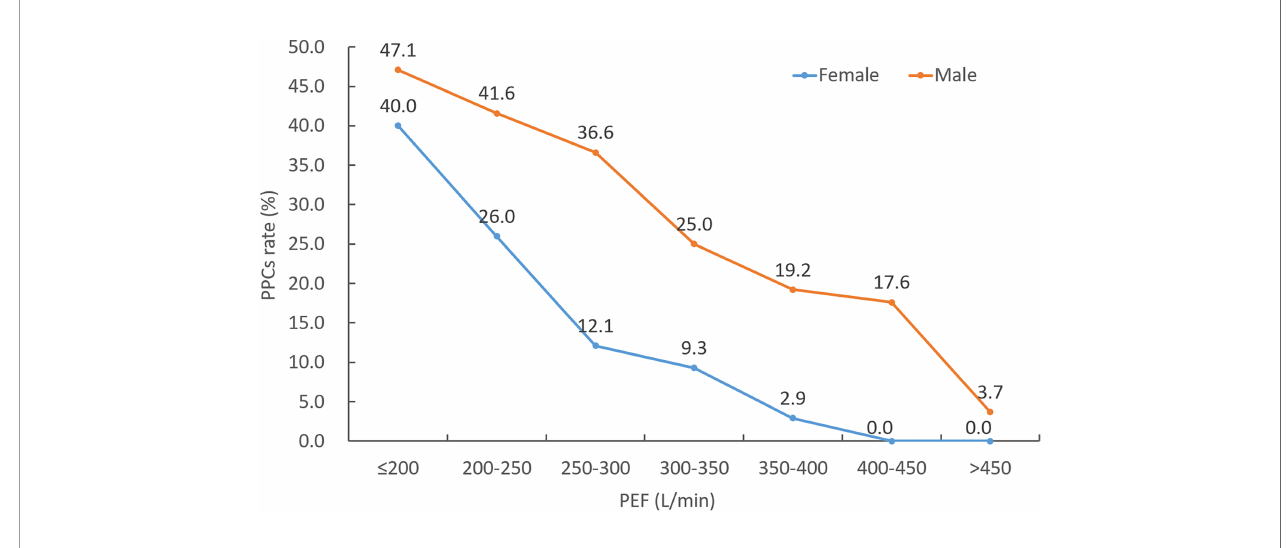
FIGURE 1 | The incidence of PPCs in different ranges of